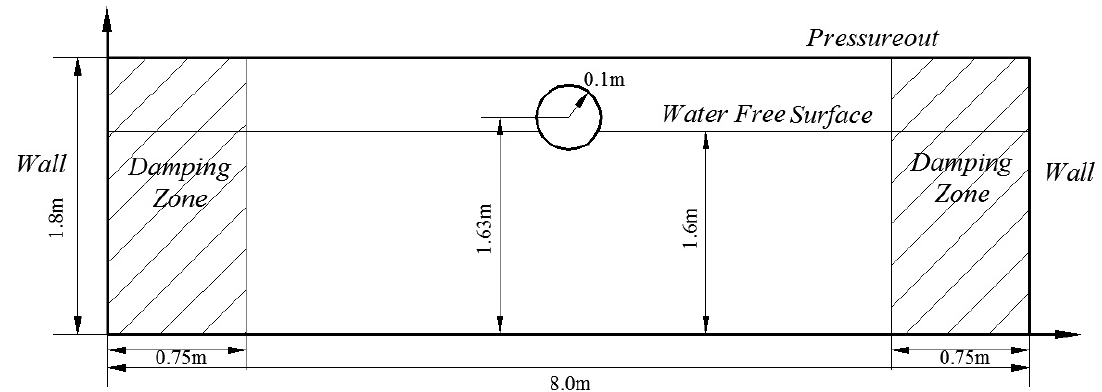
Figure 6. Computational domain of the free decay problem of a circular